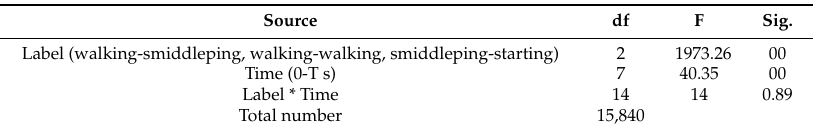
Table 5. Main e ff ect test table.